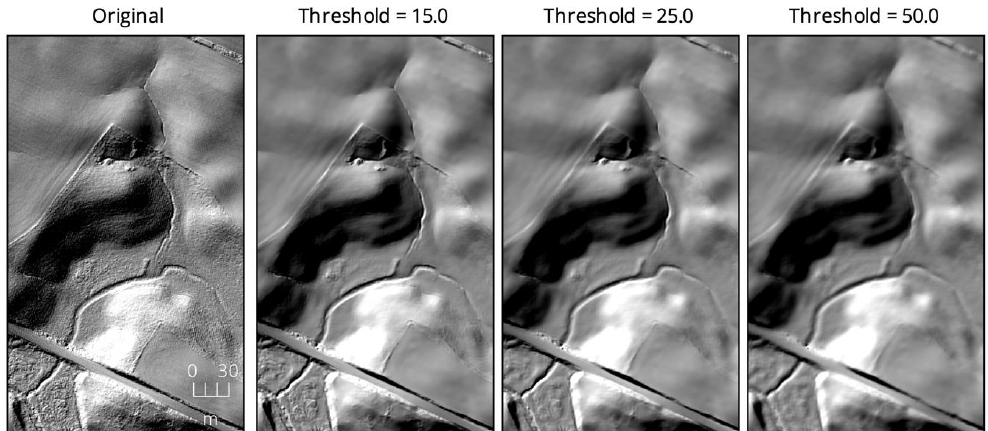
Figure 6. The e ff ects of altering the normal di ff erence threshold angle value from 15 ◦ to 50 ◦ in the FPDEMs. Each smoothing operation was run with a 15 × 15 filter size and 5 elevation-update iterations. Images present portions of the shaded relief images extracted from each DEM.